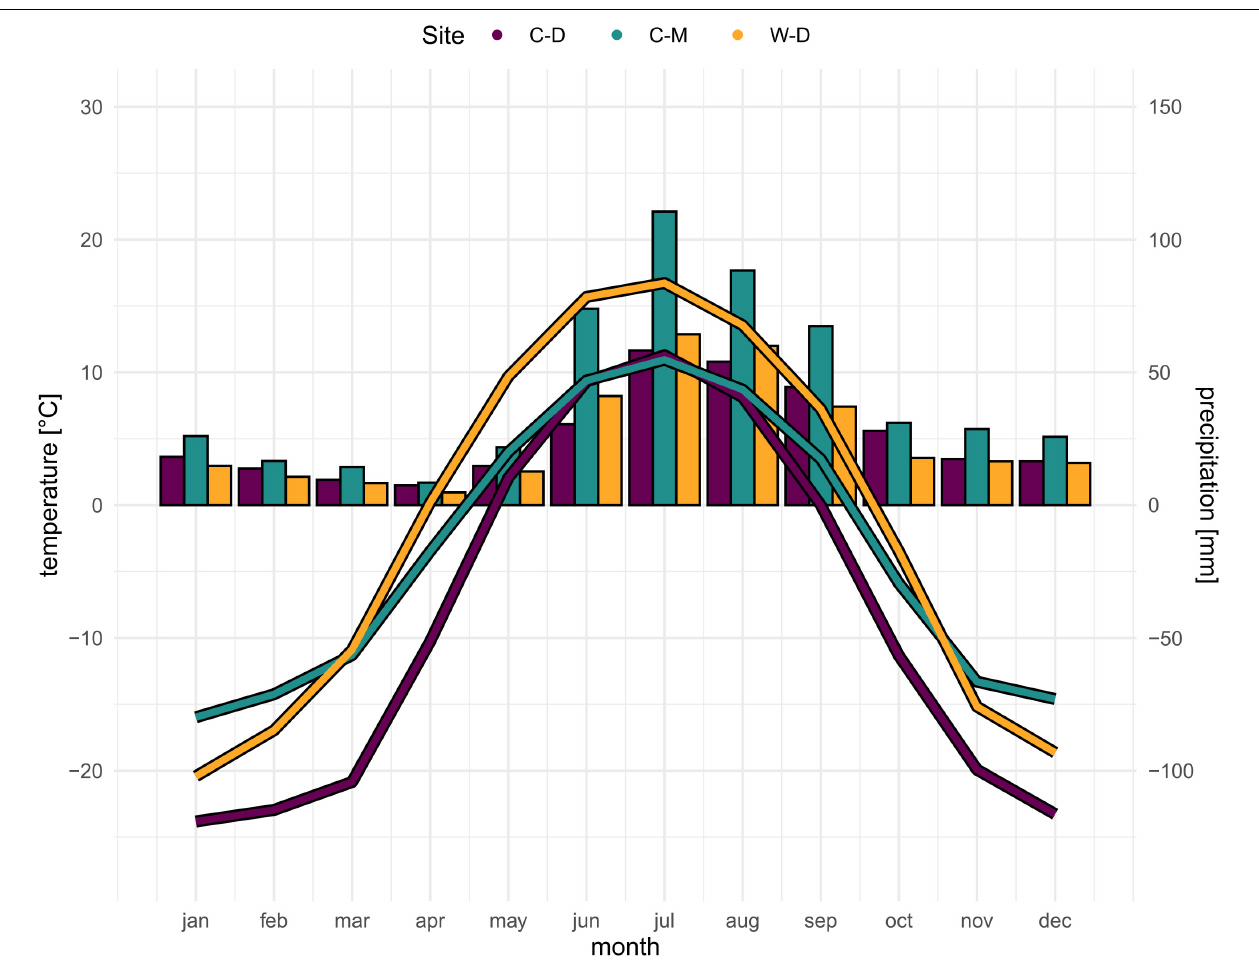
FIGURE 1 | Site-specific climatic conditions (SNAP, 2019). Bars showing precipitation sum per month, curve showing average temperature per month for the period 1970–2016. Purple = Brooks Range (C-D), Green = Denali National Park (C-M), Orange = Bluff